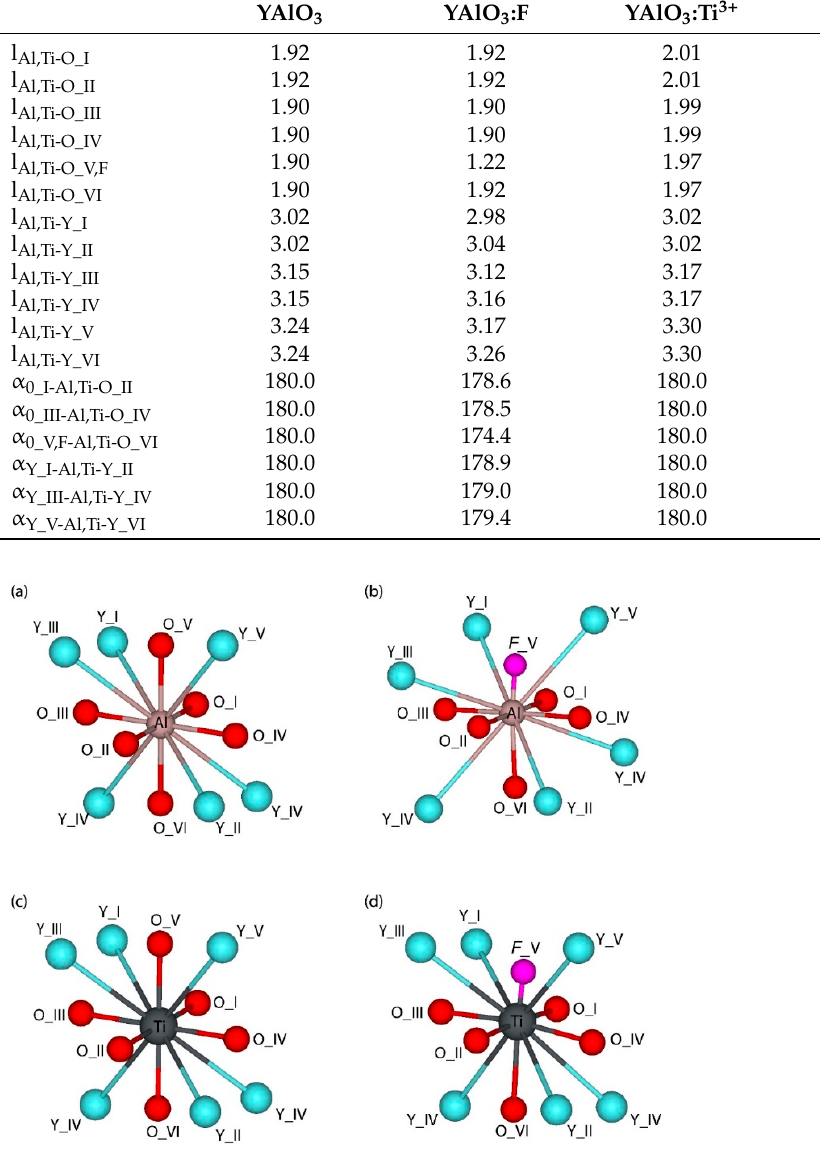
Figure 2. Equilibrium positions of oxygen octahedra in the 2 × 2 × 2 supercell structure of orthorhombic Pbnm YAlO 3 . ( a ) pristine YAlO 3 , ( b ) YAlO 3 with F -center, ( c ) YAlO 3 containing Ti 3+ ion and ( d ) YAlO 3 containing Ti 2+ ion substituted for host Al 3+ ion. See Table 3 for bond lengths and angles. Table 3. Atomic structure of pristine and Ti-doped YAlO 3 crystals in orthorhombically distorted perovskite structure. Bond lengths l are given in Å and bond angles α are in degrees. For atomic notations please see Figure 2.